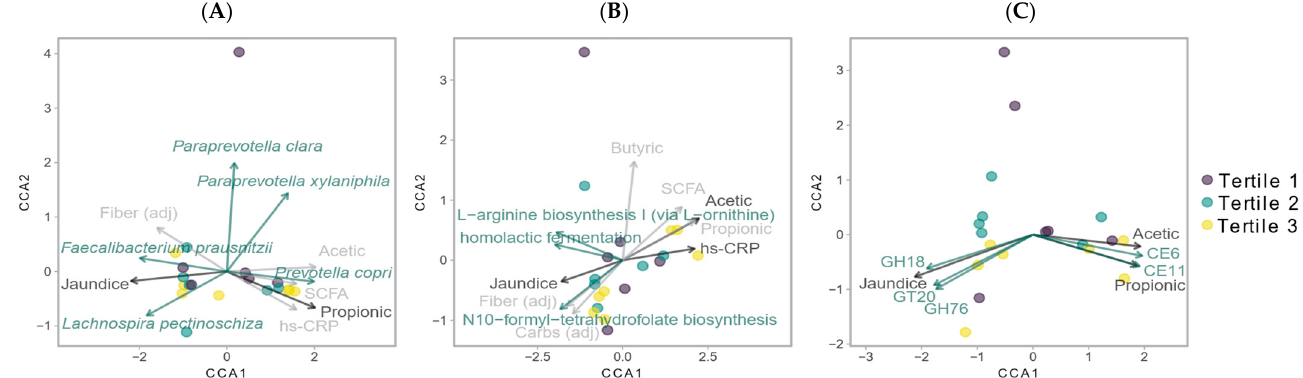
Figure 2. Canonical correspondence analysis showing drivers of β -diversity of ( A ) microbial composition, ( B ) MetaCyc pathways and ( C ) CAZymes.